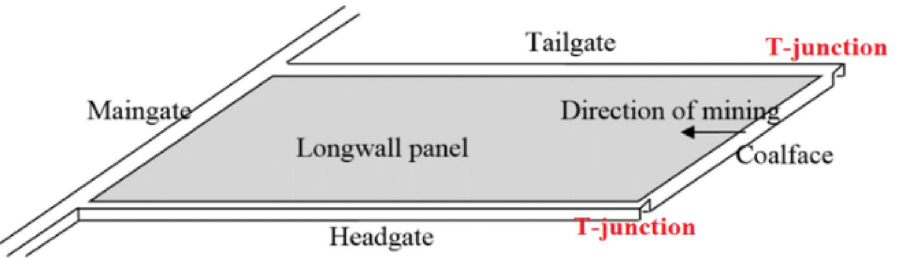
Figure 1. Schematic view of coalface, roadways, and T-junctions in a longwall panel.